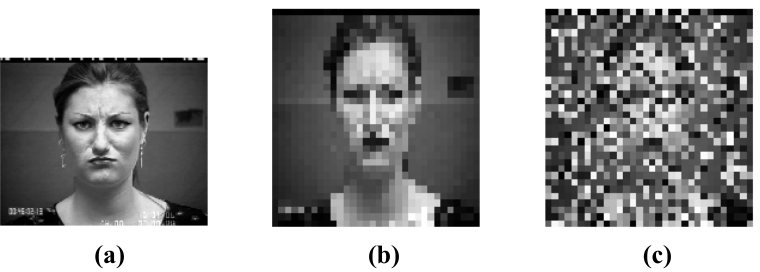
Figure 5. A corrupted image example ( a ) Original image of 640 × 490 pixels; ( b ) Resized image of 32 × 32 pixels; ( c ) 50% corrupted image.